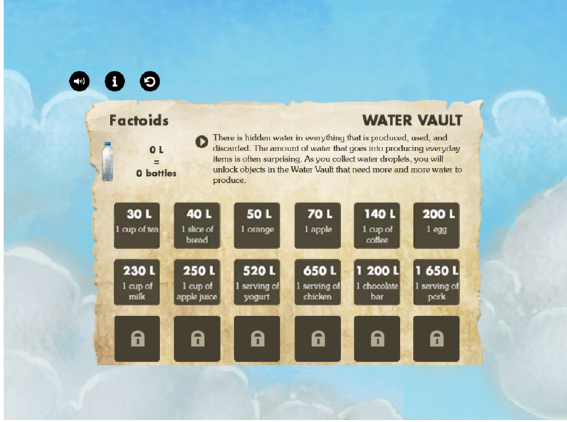
Figure 6. Water vault. Figure 7. Main page of digital student